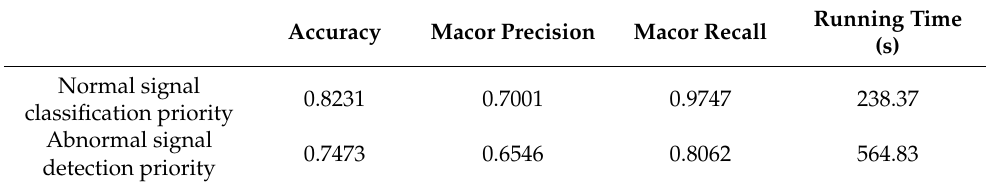
Table 6. Performance comparison of the normal signal classification priority model and the abnormal signal detection priority